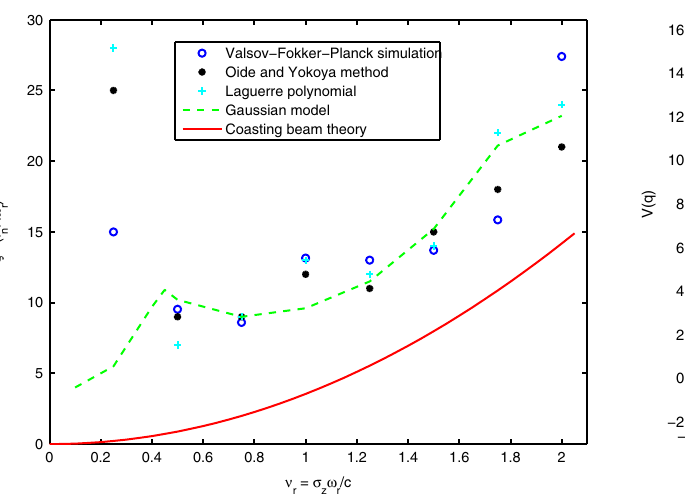
FIG. 12. The potential well at the threshold current I th 0 : 042 pC = V in the SLC damping ring. Note that most distortion ¼ ! (cid:1) =c in the Q ¼ 1 r r z occurs near the bottom of the